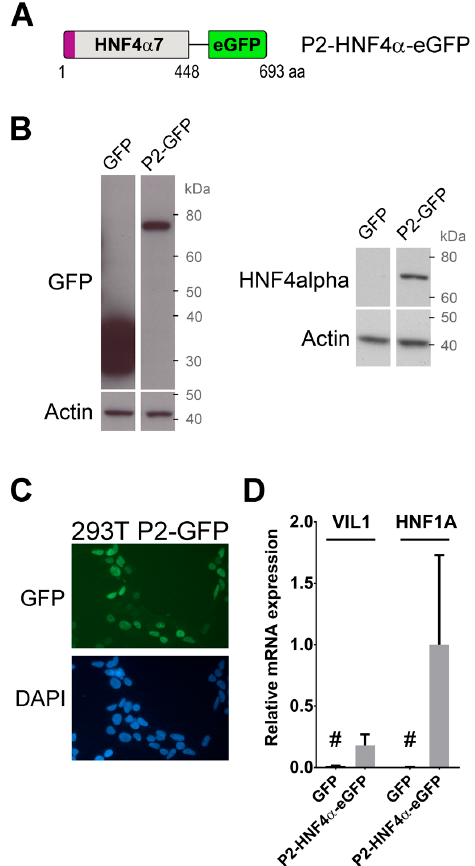
Figure 1. The P2-GFP construct displays transcriptional functions associated with hepatocyte nuclear factor 4 α (HNF4 α ) in cellulo . ( A ) Structure of the bait used for the GFP-Trap assay. The sequence of eGFP was fused at the C-terminal end of HNF4 α 7 isoforms and separated by a linker sequence of six amino acids; ( B ) expression of the P2-GFP construct was tested by infecting HEK293T cells with lentivirus expressing P2-GFP, or the GFP tag alone. Total protein extracts were analyzed by western blot using an antibody against GFP (left panel) or against HNF4 α (right panel); ( C ) nuclear localization of P2-GFP was determined by fluorescence microscopy on HEK293T cells stably expressing the construct after lentiviral infection. Nuclei were counterstained using DAPI; ( D ) total RNA was extracted from P2-GFP HEK293T cells or control GFP cells and the expression of VIL1 and HNF1A gene transcripts levels measured by qPCR. Expression was normalized to the MRPL19 housekeeping gene. P2-GFP are n = 3, GFP control are n = 2. # = background noise since these genes are not expressed in HEK293T cells.